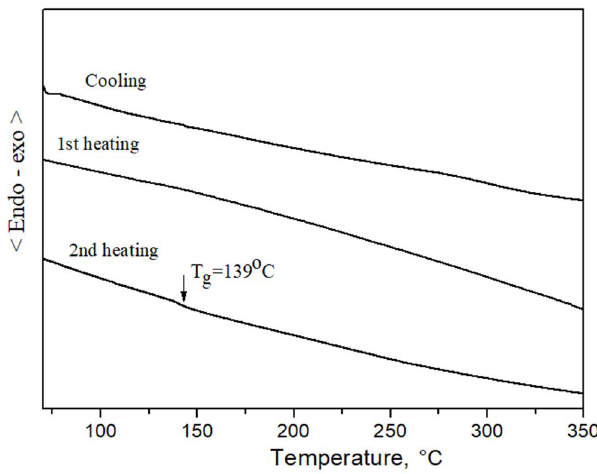
Figure 3. DSC curves of the derivative H2 .